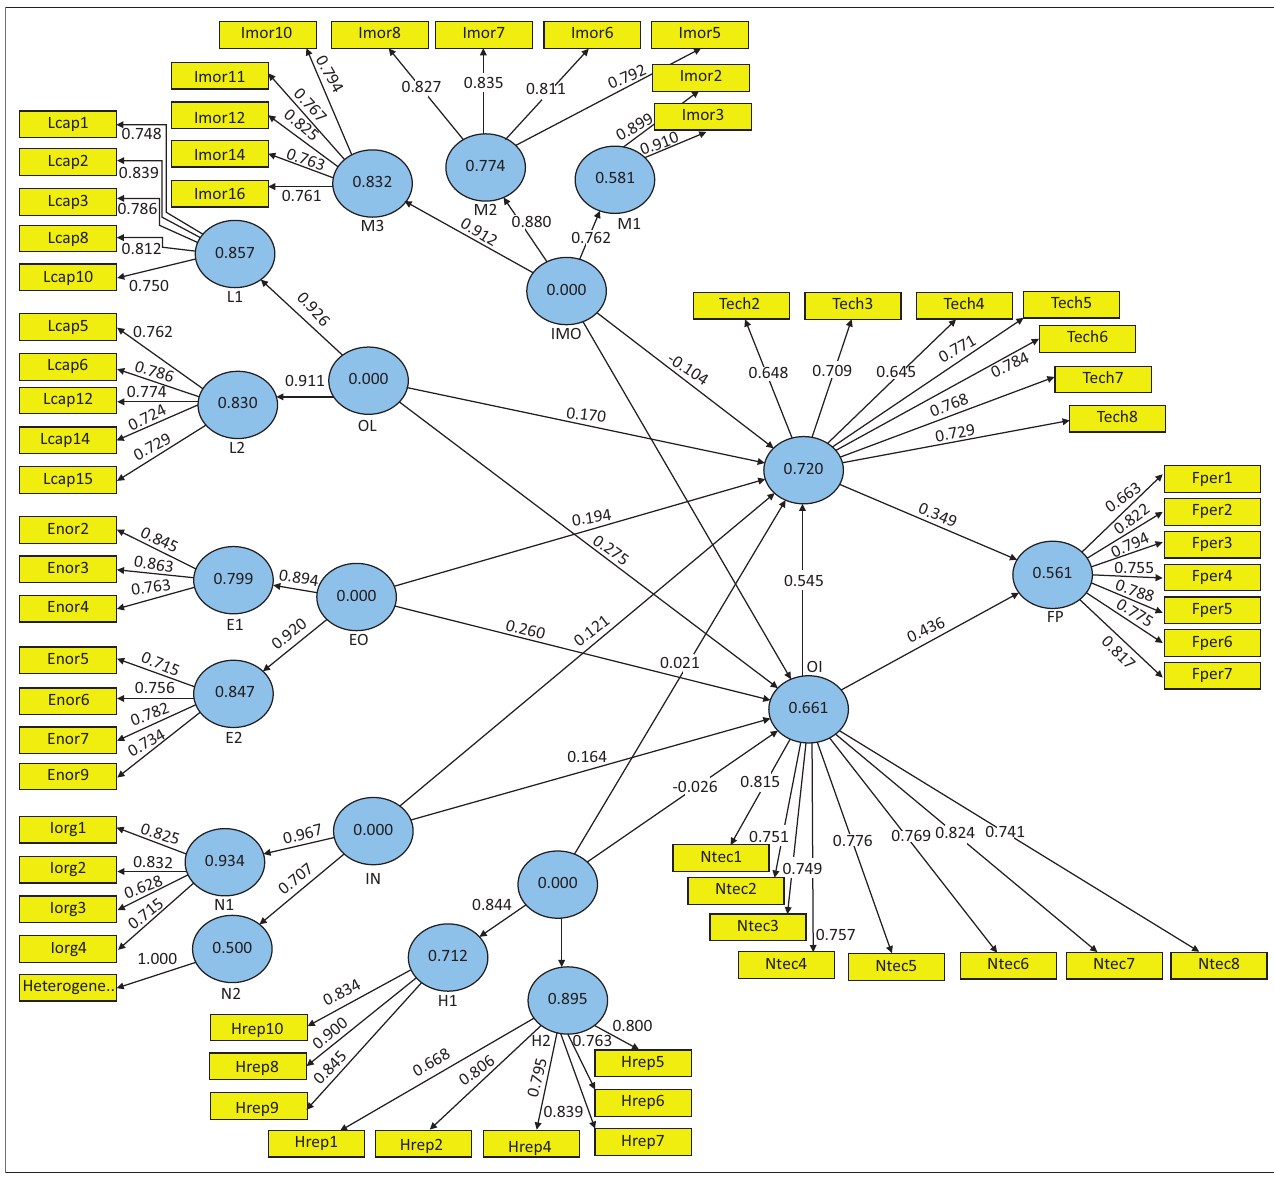
FIGURE 5: Full model of innovation (extending the manifest